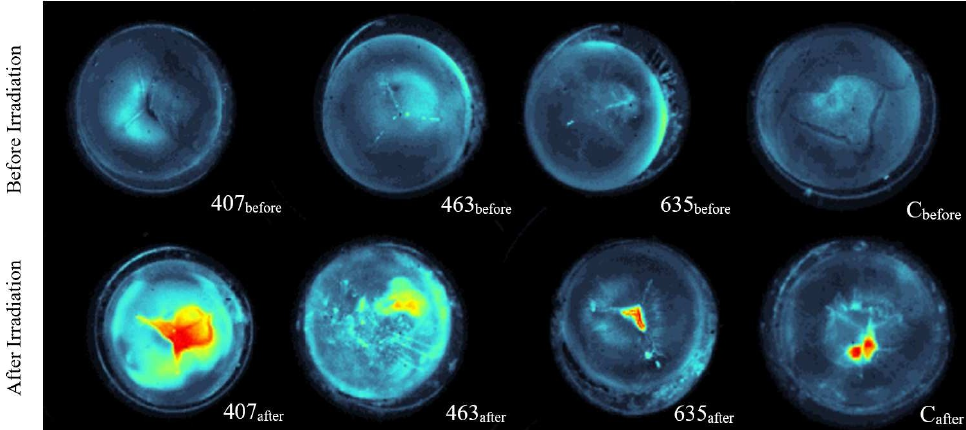
Figure 4. False color images converted from captured gray images. The first three lenses 407 before , 463 before and 635 before in the upper row were taken before irradiation and in the lower row the same lenses 407 after , 463 after and 635 after were taken after irradiation with 407 nm, 463 nm and 635 nm. The last lens C before and C after illustrates an unirradiated control lens. Here, a false color image was generated before and after a storage period of 24